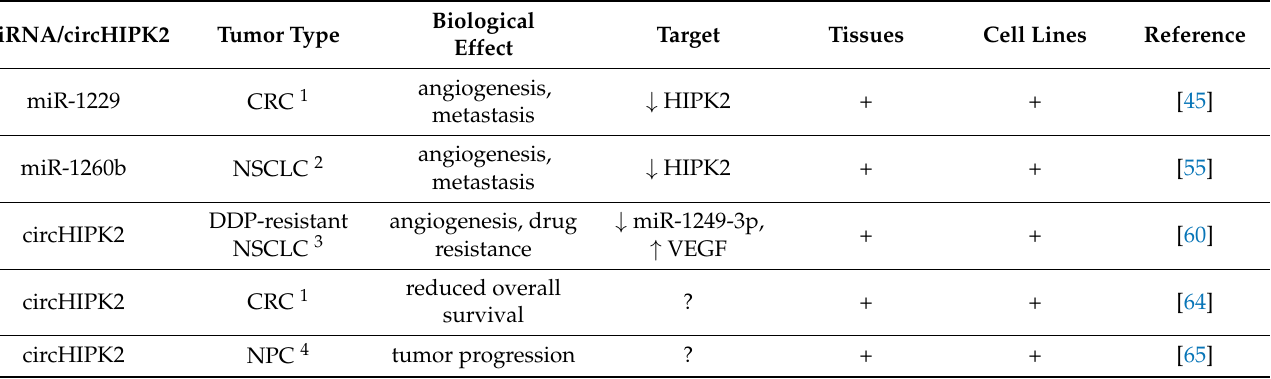
Table 1. Summary of the miRNA/HIPK2 and circHIPK2 expression described in the